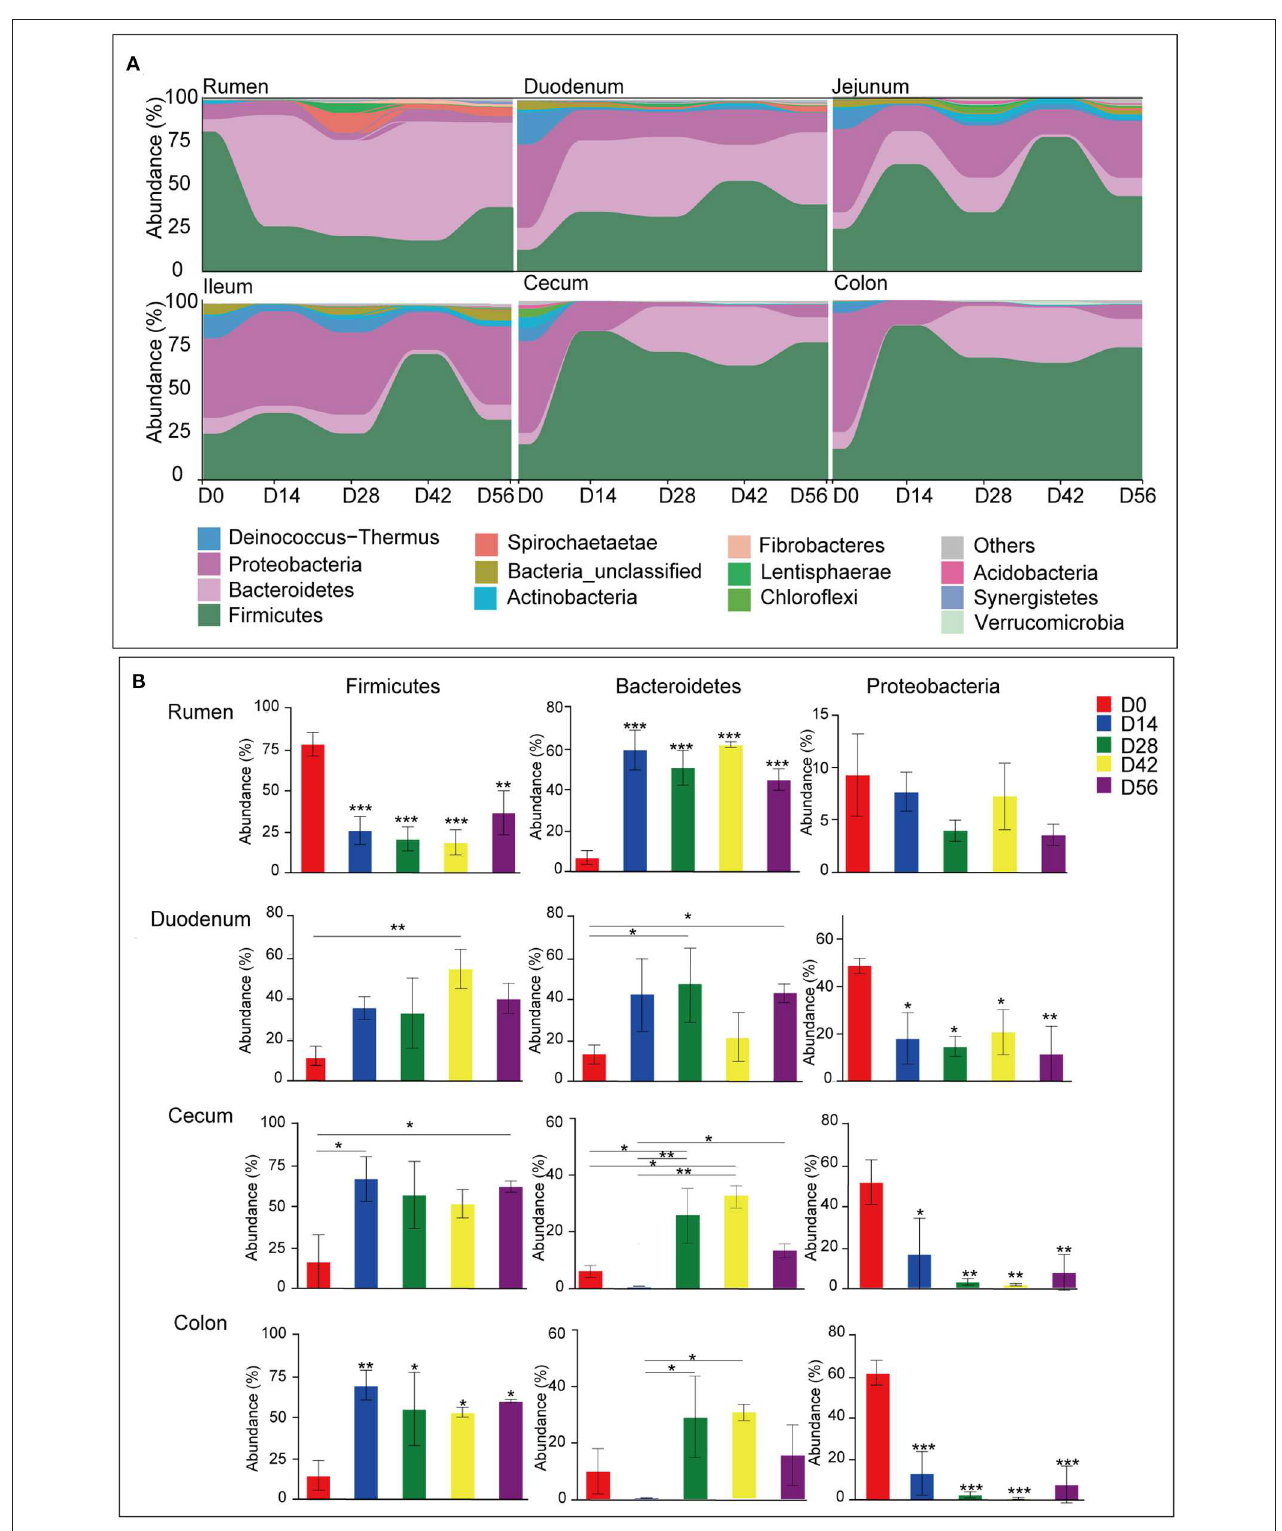
FIGURE 3 | Microbiota composition at the phylum level. (A) Bacterial community composition changes as kids aged in each gastrointestinal tract (GIT) region. (B) Comparison of relative abundances of the three main bacterial phyla (Firmicutes, Bacteroidetes, and Proteobacteria) among age groups throughout the GIT region. Bars with a star symbol above their whiskers are significantly different between age groups in each GIT compartment using one-way ANOVA analysis; *0.01 < P < 0.05; **0.001 < P < 0.01; *** P < 0.001.